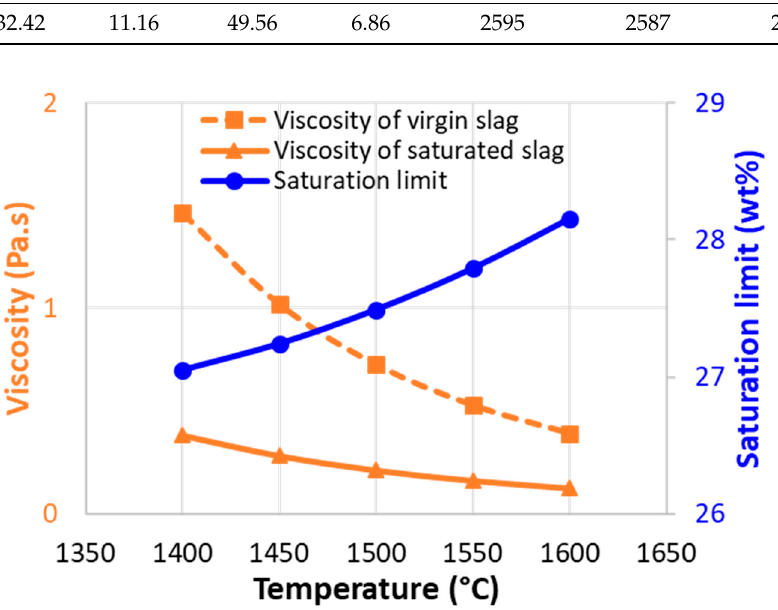
Figure 1. Viscosities of virgin slags, magnesia-saturated slags, and magnesia saturation limits against temperature.